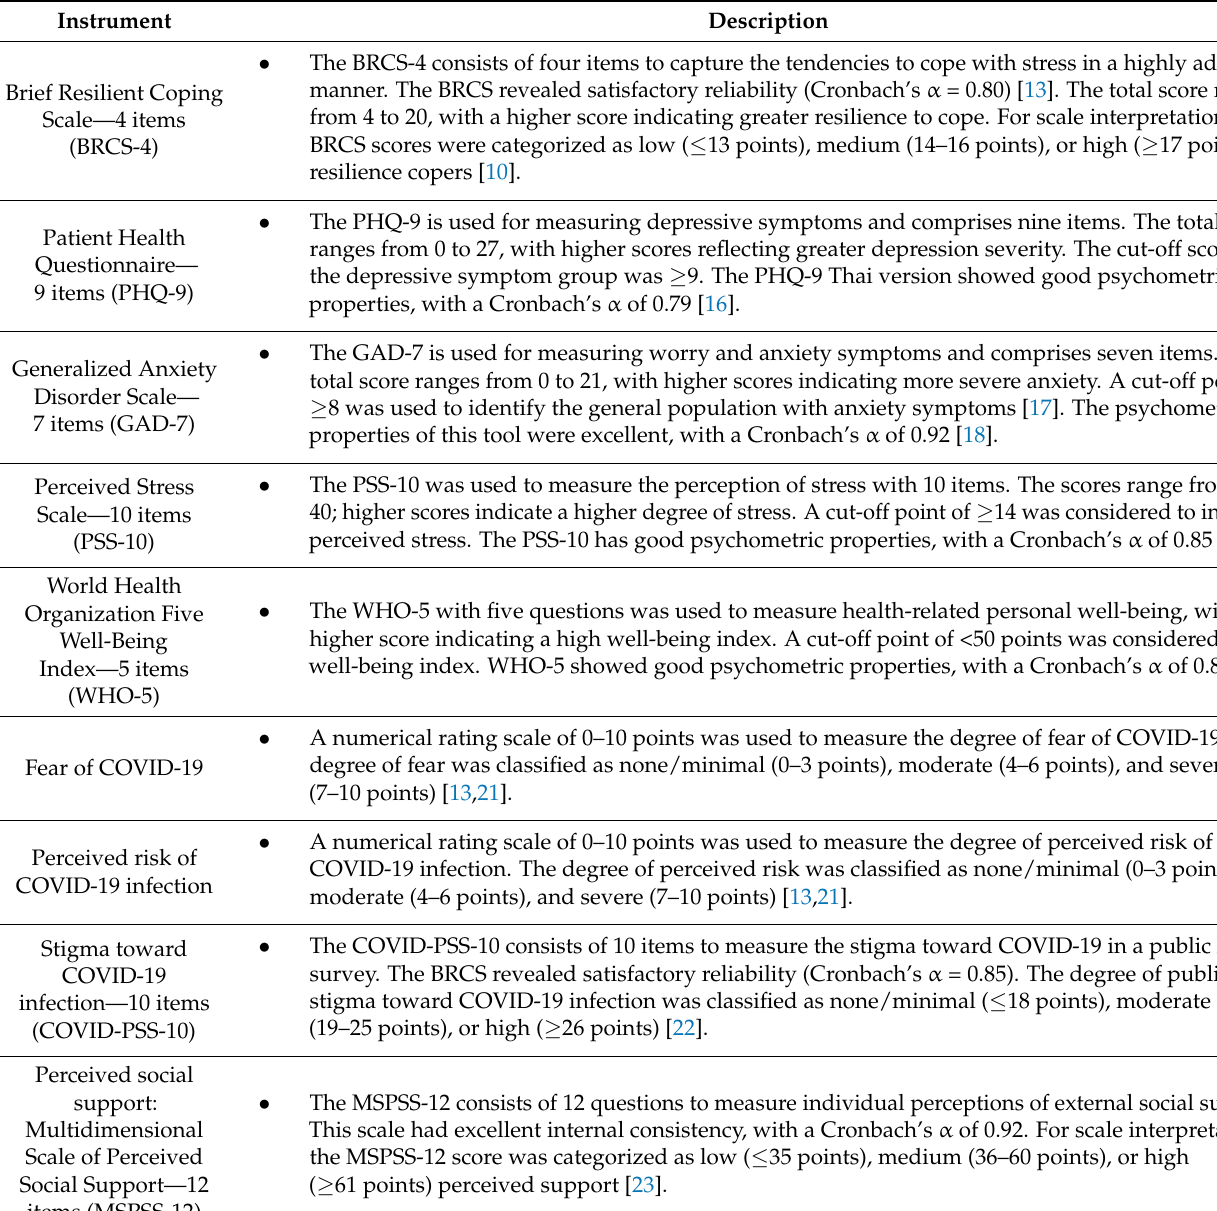
Abbreviations: COVID-19, coronavirus disease